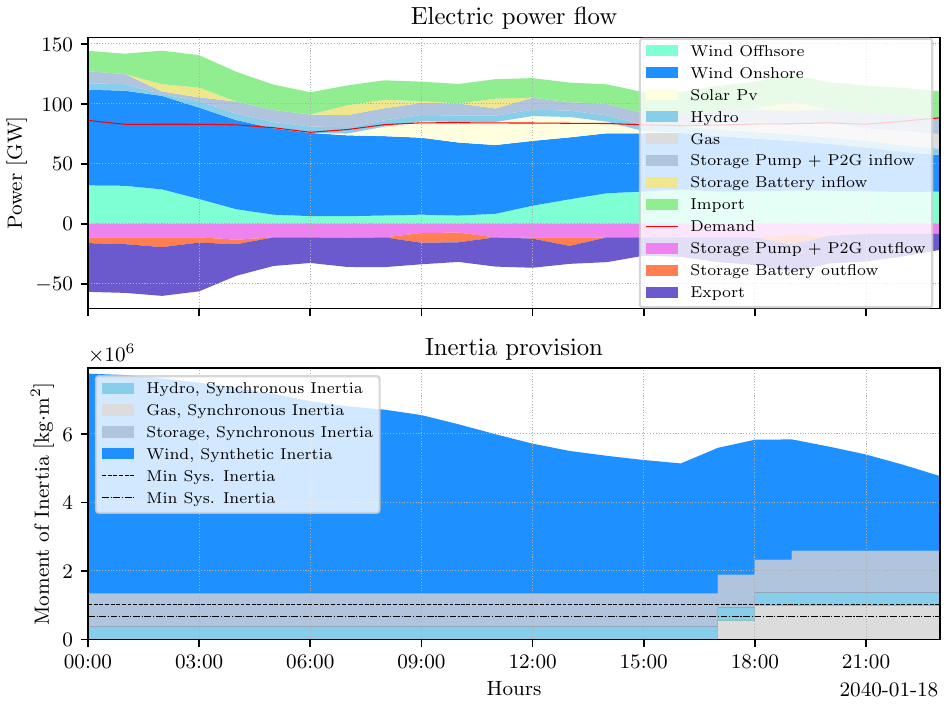
Figure 6. Visualisation of a 24 h time period considering inertia constraints of the NT scenario and the parameter combination 1Hz/s, 2s. The top subplot illustrates results of the power output flows, and the bottom subplot shows the supplied moment of inertia